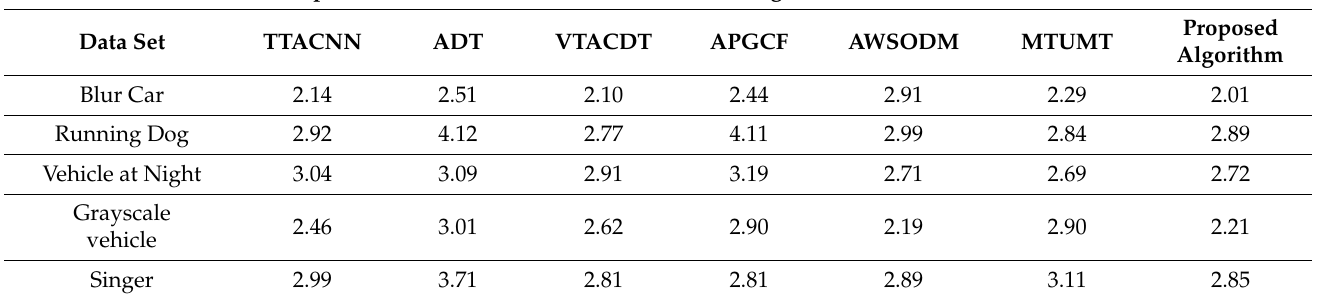
Table 1. Comparison of state-of-the-art algorithms in terms of execution time (sec.). Comparison of Execution Time (in Seconds) of Algorithms (Min. 300